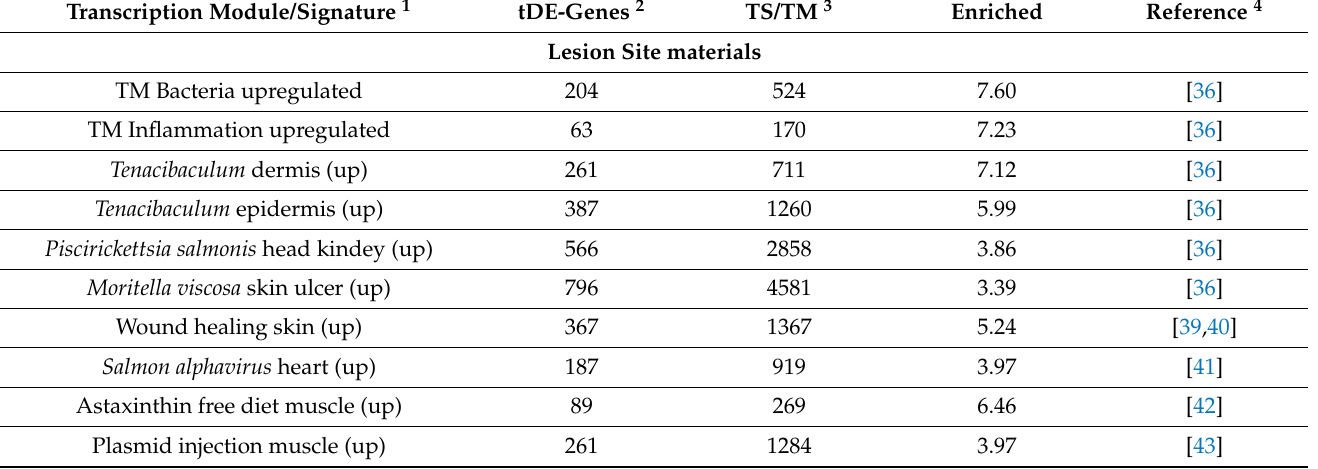
Table 9. DEG counts and enrichment scores for TM and TS classifications that were highly enriched prior to target prediction in Lesion Site and Head-Kidney